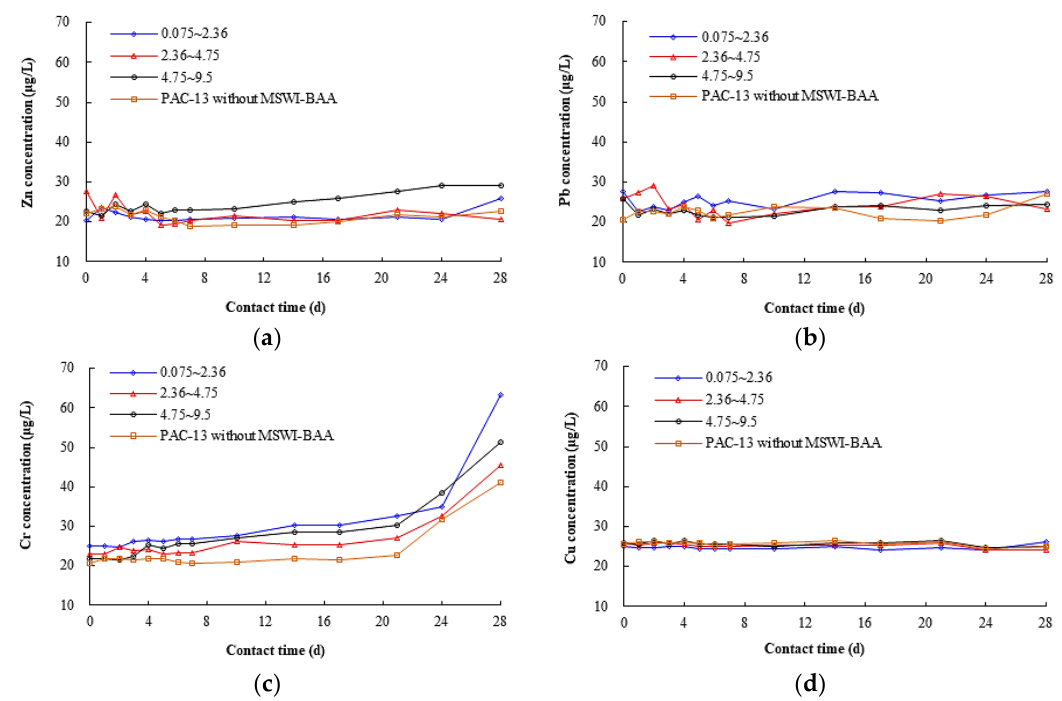
Figure 6. Variation of leaching concentrations of each heavy metal with contact time for PAC-13 specimens with and without MSWI-BAA: ( a ) Zn; ( b ) Pb; ( c ) Cr; and ( d ) Cu.